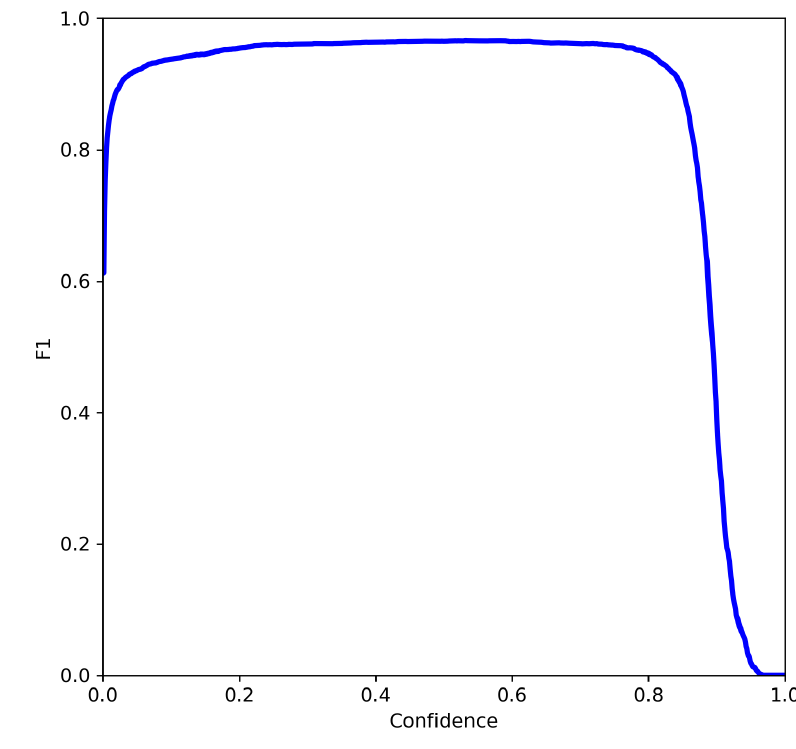
Figure 6. F1 score curve for the YOLOv5x model using the OSS